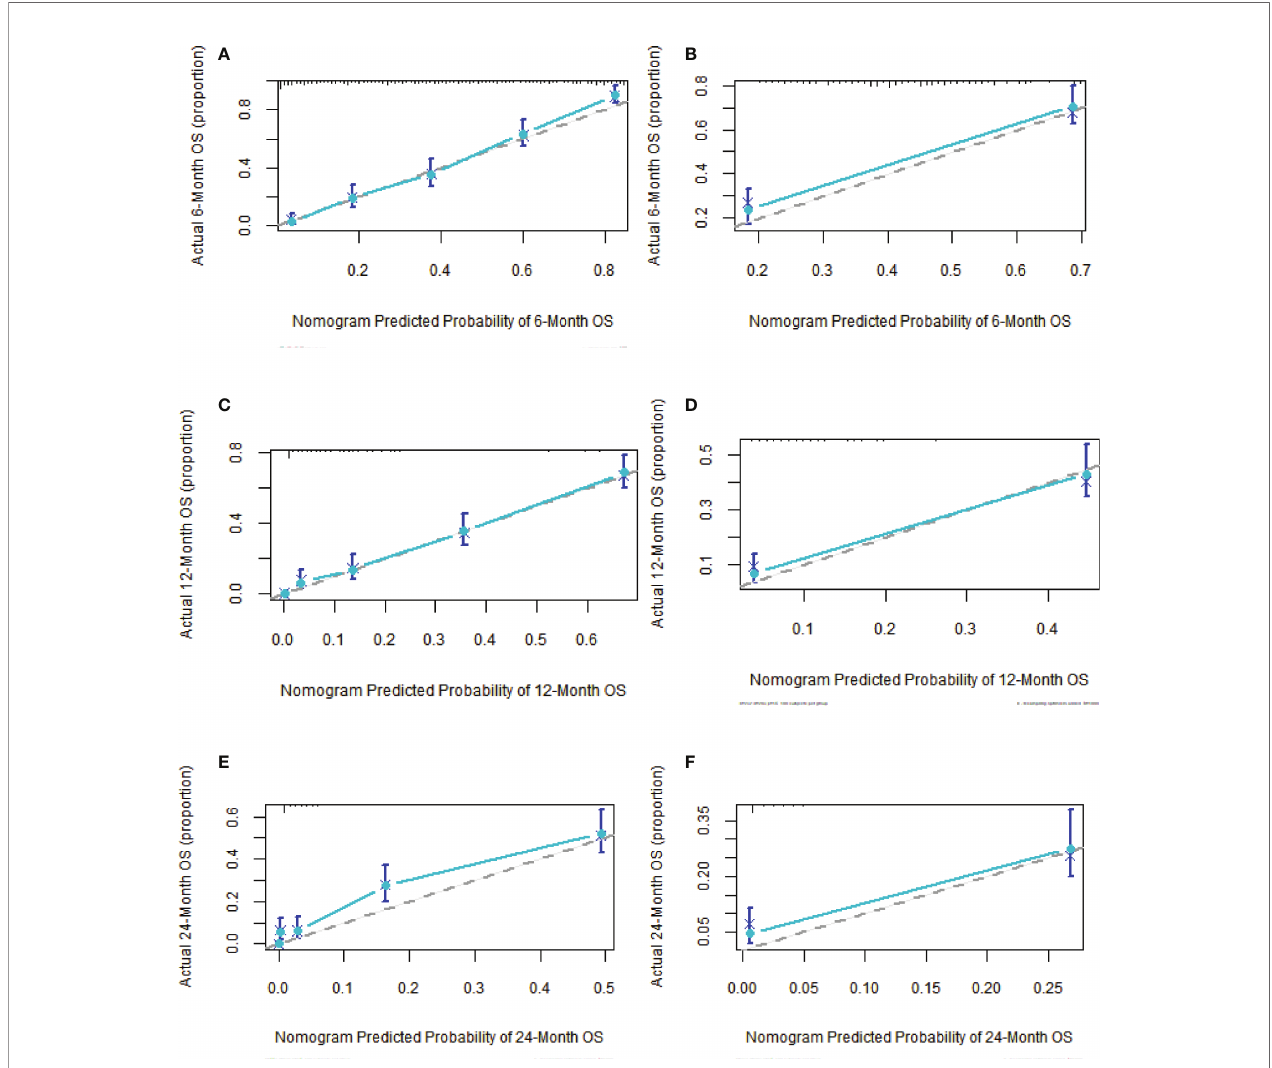
FIGURE 8 | Calibration curves of nomogram (A, C, F) in training group at 6, 12 and 24 months; calibration curves of nomogram (B, D, E) in validation group at 6, 12 and 24